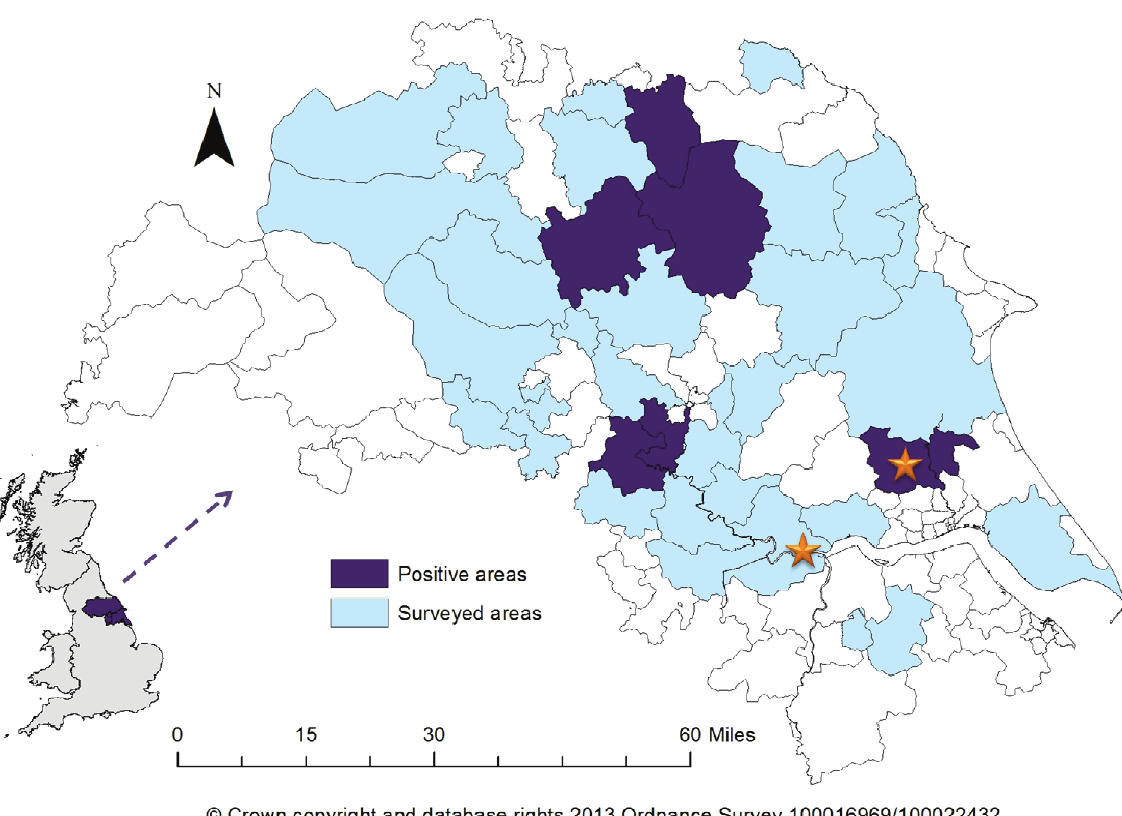
Figure 1. Map of Yorkshire and the Humber showing surveyed areas and areas with a minimum of one positive serum sample recorded. Stars indicate location of previous acute cases. Insert shows location of Yorkshire within the United